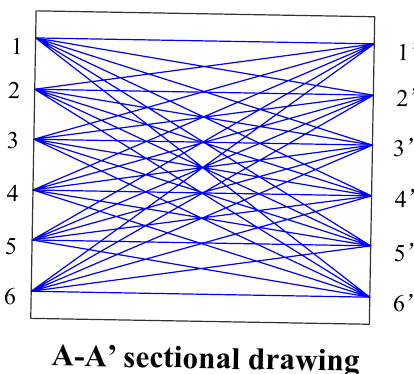
Figure 12. Diagram of launching and receiving ultrasonic test points.